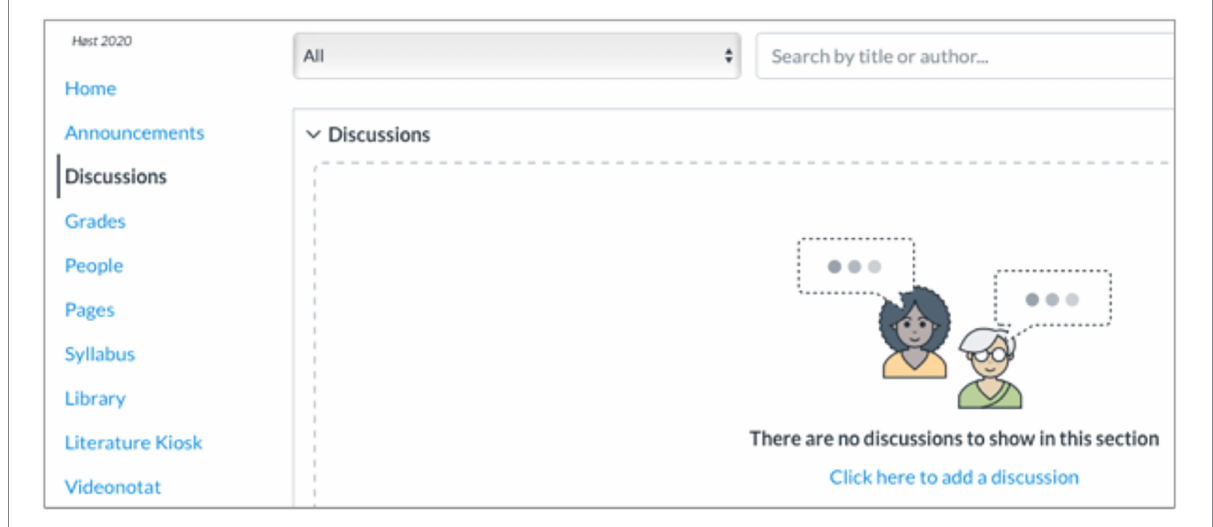
FIGURE 3 Screenshot of the discussions feature with no threads in Canvas.